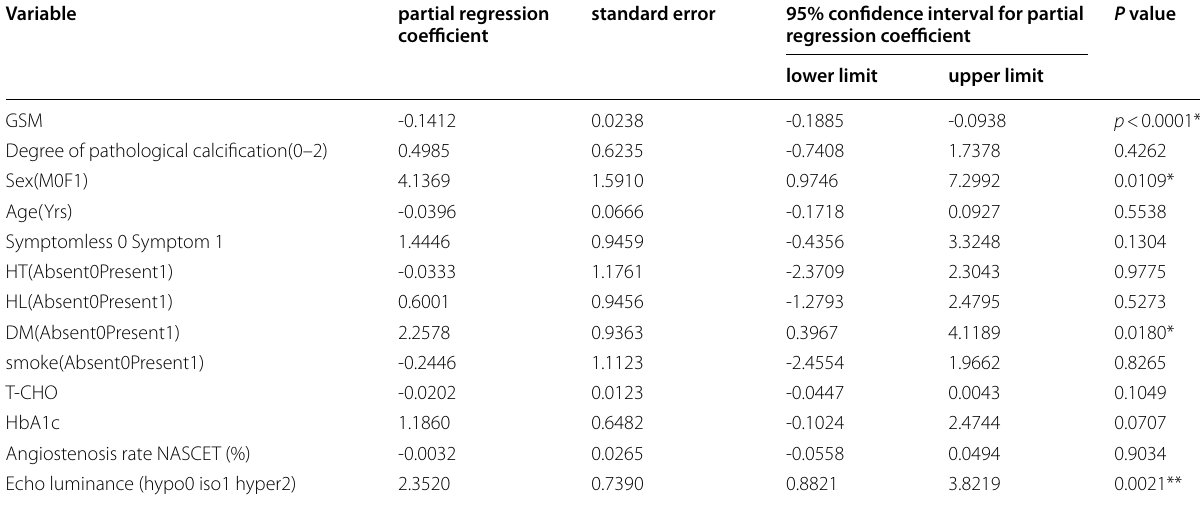
Table 3 Single regression analysis of plaque hardness and patient